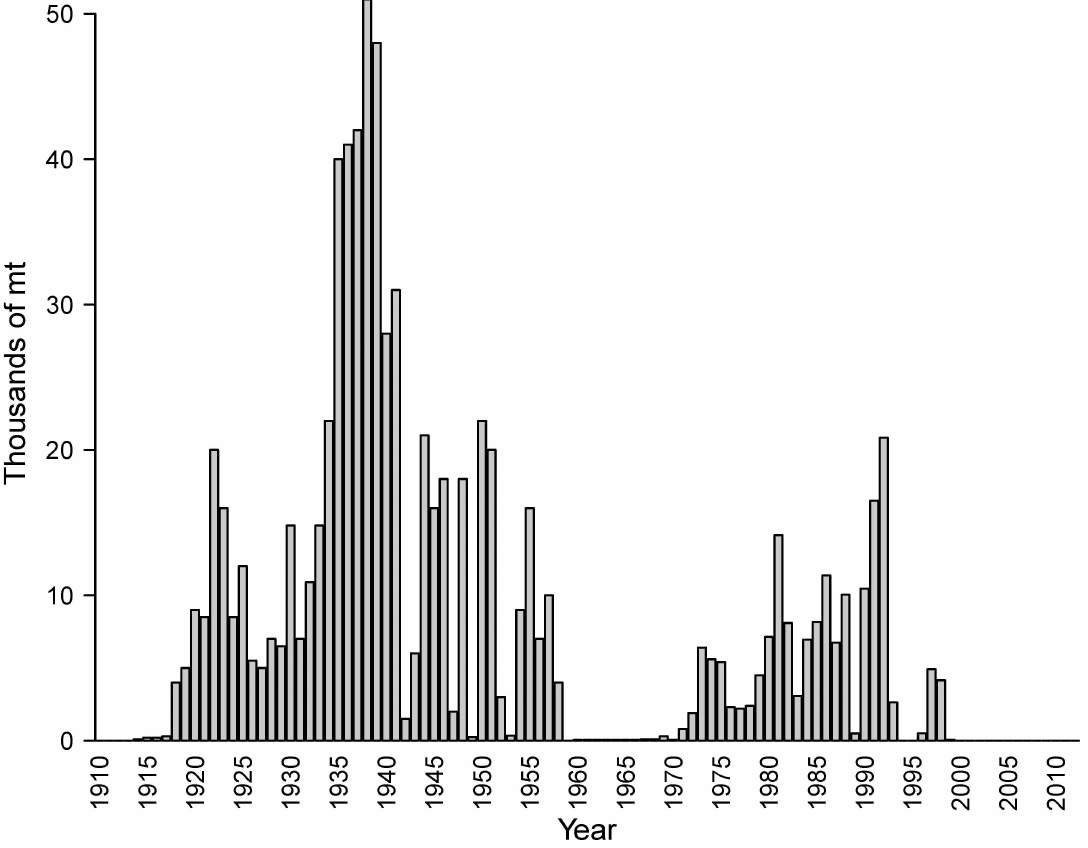
Fig 1. Commercial harvestsof Pacific herring reported for Prince William Sound, 1914through 2012